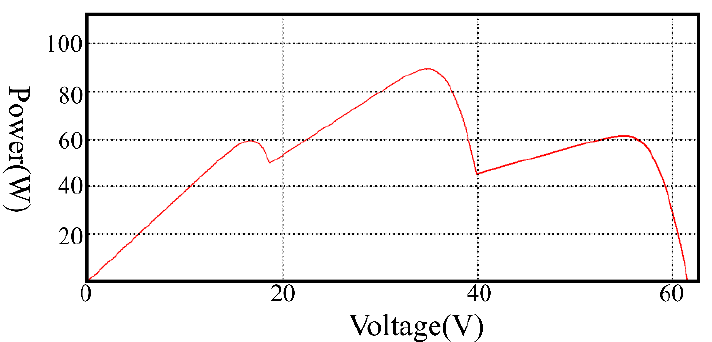
Figure 8. The P-V curve under PSC (1 k, 0.7 k and 0.3 kW/m 2 ).